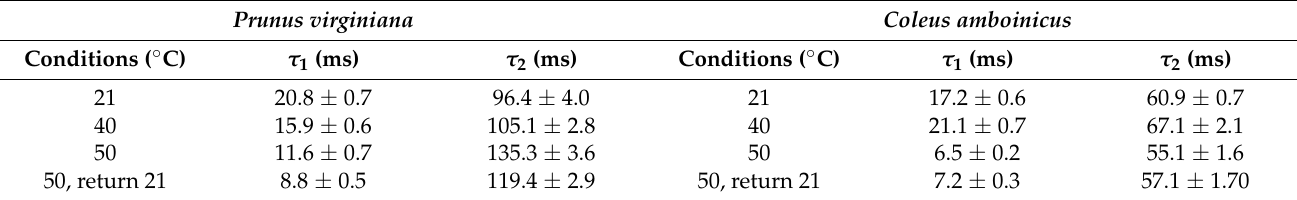
Table 1. Lifetime values of heat stressed Prunus virginiana and Coleus amboinicus